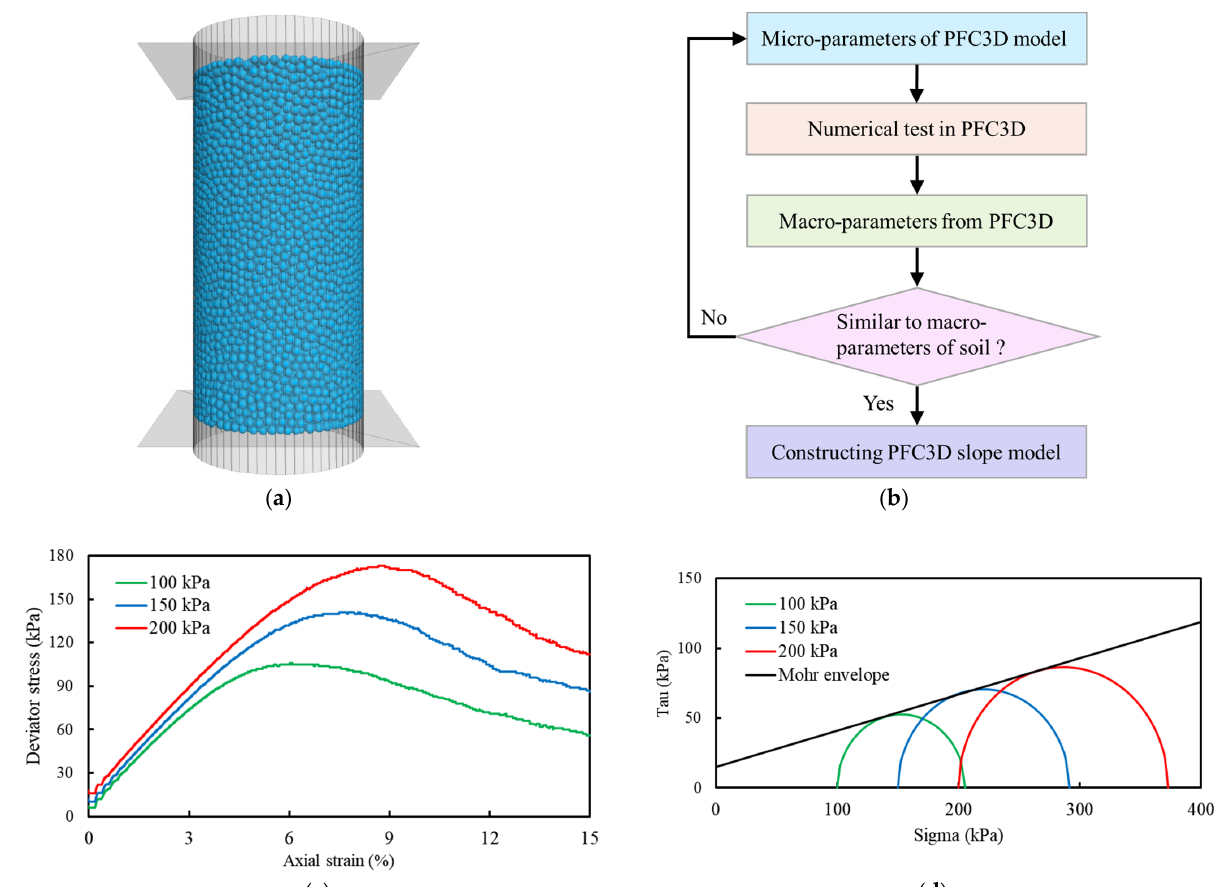
Figure 6. Stress curves simulated by PFC3D.